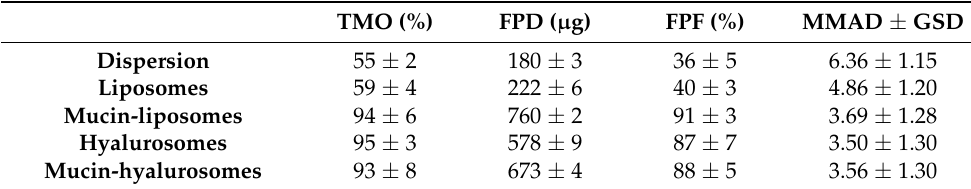
Table 3. Total mass output (TMO), fine particle dose (FPD), fine particle fraction (FPF) and aero- dynamic diameter (MMAD) of beclomethasone dipropionate in dispersion or loaded into vesicles. Average values ± standard deviations are reported ( n =